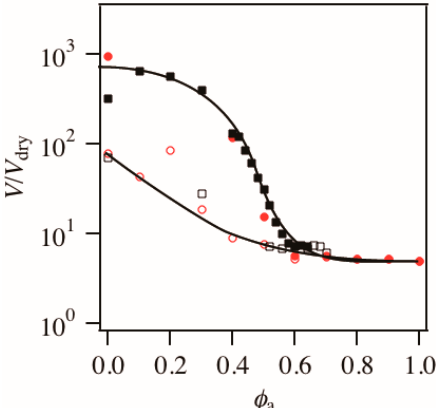
Figure 3. The degree of swelling V / V dry of the carboxylated SR gels with cross-linking times of 2.7 h (circle) and 3 h (square) as a function of acetone volume fraction, φ a . Filled and open symbols denote shrinking and swelling processes, respectively. The solid lines are eye guides.